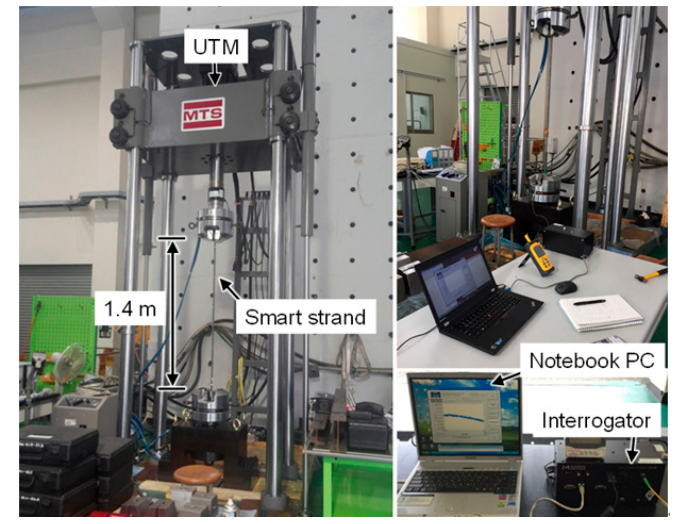
Figure 7. Tension test setup of strands using a universal testing machine.